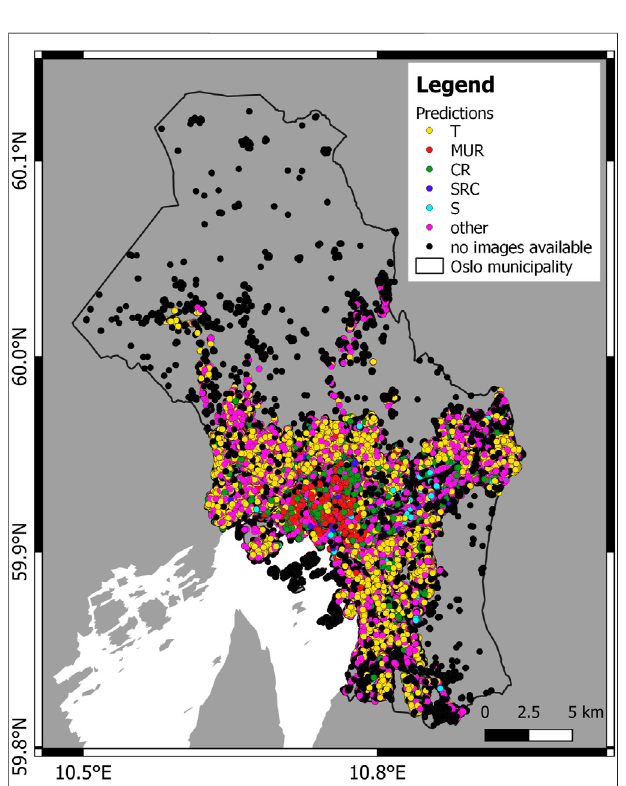
FIGURE6 | Distributionofthe predicted buildingtypologies in Oslo,also including the categories “ other ” and “ no images available ” .